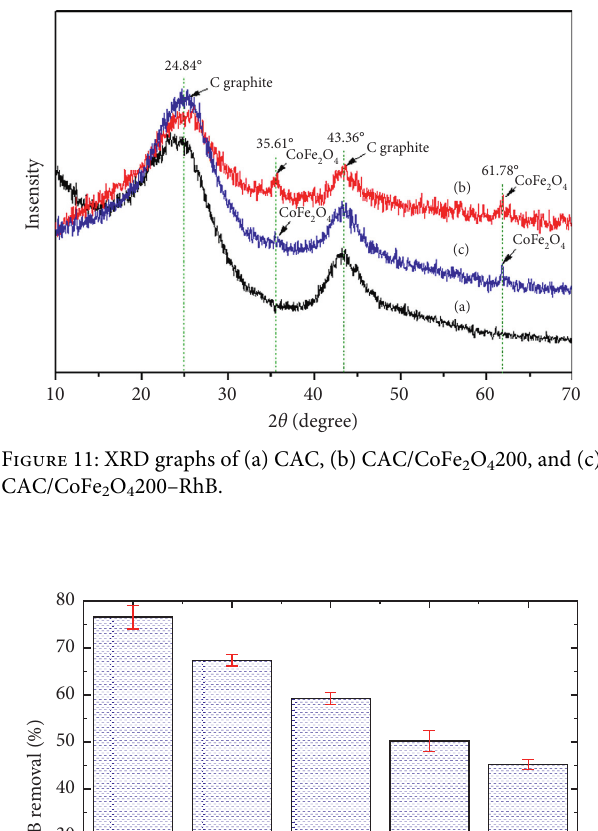
2 O 4 200 after